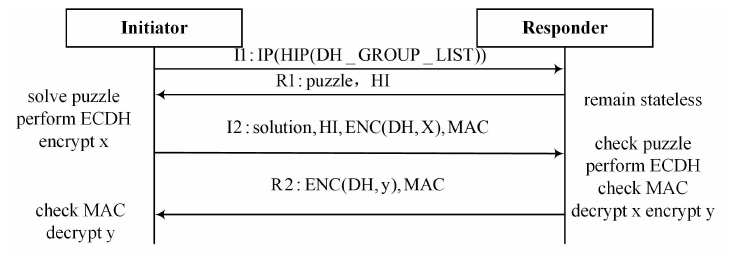
Figure 2. HIP-DEX